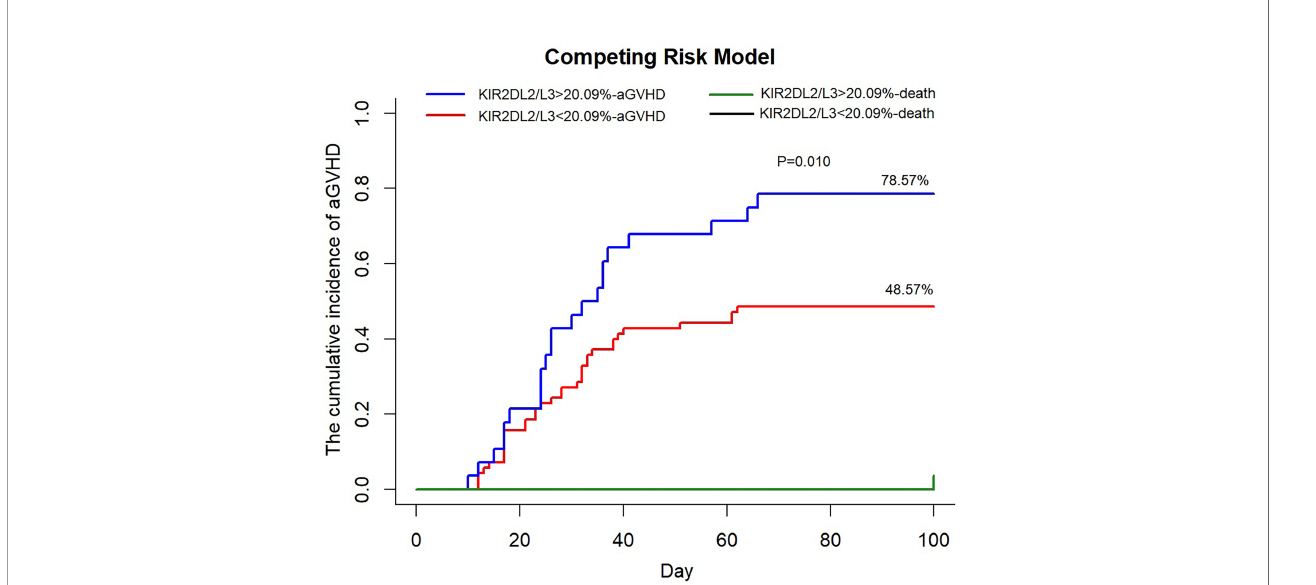
FIGURE 4 | An increased proportion of KIR2DL2/L3 single-positive/NKG2C+ NK cells correlated with higher incidence of aGVHD. KIR2DL2/L3sp%, the proportion of KIR2DL2/L3 single-positive/NKG2C+ NK cells among NKG2C+ NK cells; aGVHD, acute graft-versus-host disease. In competing the risk model, 100 days cumulative incidence of aGVHD in the cohort (KIR2DL2/L3 single-positive/NKG2C+ NK cells < 20.09%, n = 69, red line; KIR2DL2/L3 single-positive/NKG2C+ NK cells > 20.09%, n = 27, blue line) after HSCT and 100 days cumulative incidence of death, considered as competing risk event (KIR2DL2/L3 single-positive/NKG2C+ NK cells < 20.09%, n = 1, black line; KIR2DL2/L3 single-positive/NKG2C+ NK cells > 20.09%, n = 1, green